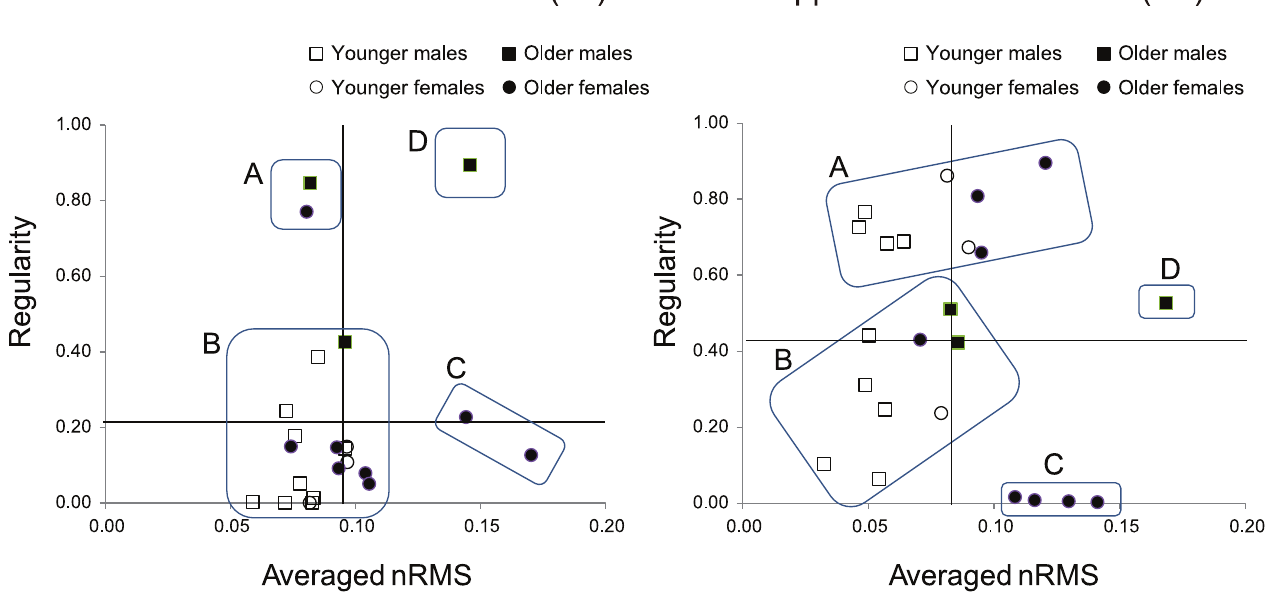
Fig 2. Relationships between the nRMS values of trunk acceleration and regularity in the ML direction. nRMS, normalized root mean square; ML, mediolateral. The solid line shows the averagevalues. Filled circles show older adults, and open circles show